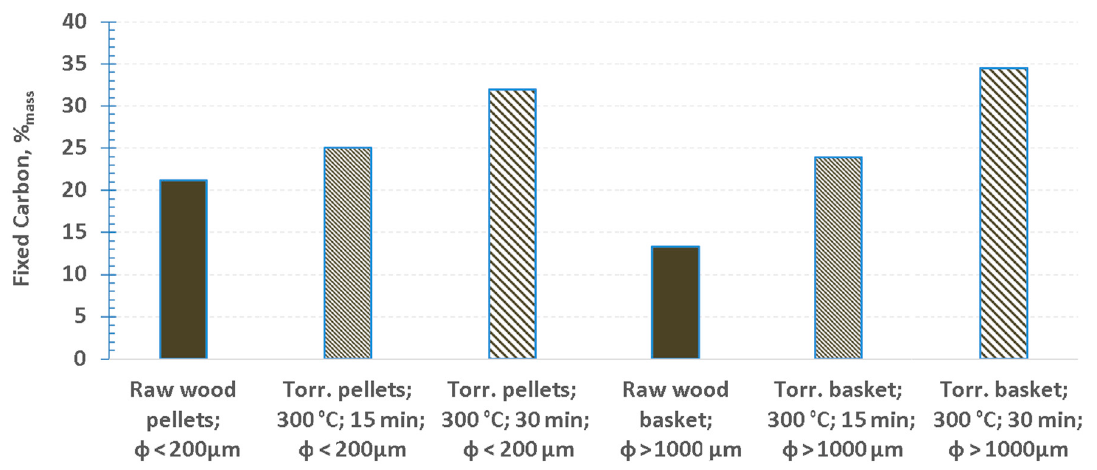
Figure 6. Fixed carbon left after pyrolysis at 600 ° C (% mass left after pyrolysis, in comparison to the initial sample mass).